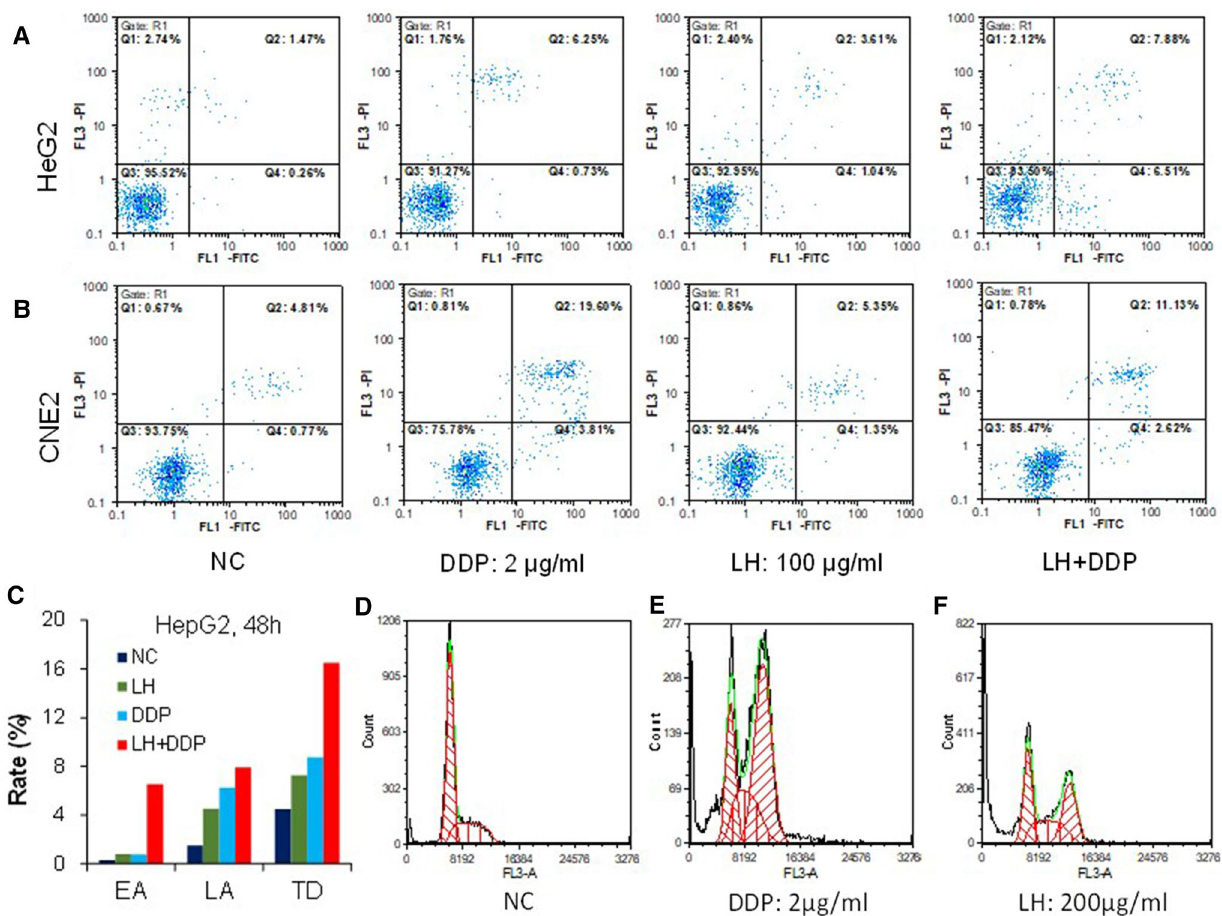
Fig. 3 Effects of levofloxacin, cisplatin and their combination on the cell cycle and apoptosis of cancer cells. A FACS analysis of apoptosis in HepG2 cells. B FACS analysis of apoptosis in CNE2 cells. C Summary data of EA, LA and TD in different groups in HepG2 cells. D FACS analysis of cell cycle in negative control group. E FACS analysis of cell cycle in DDP group. F FACS analysis of cell cycle in LH